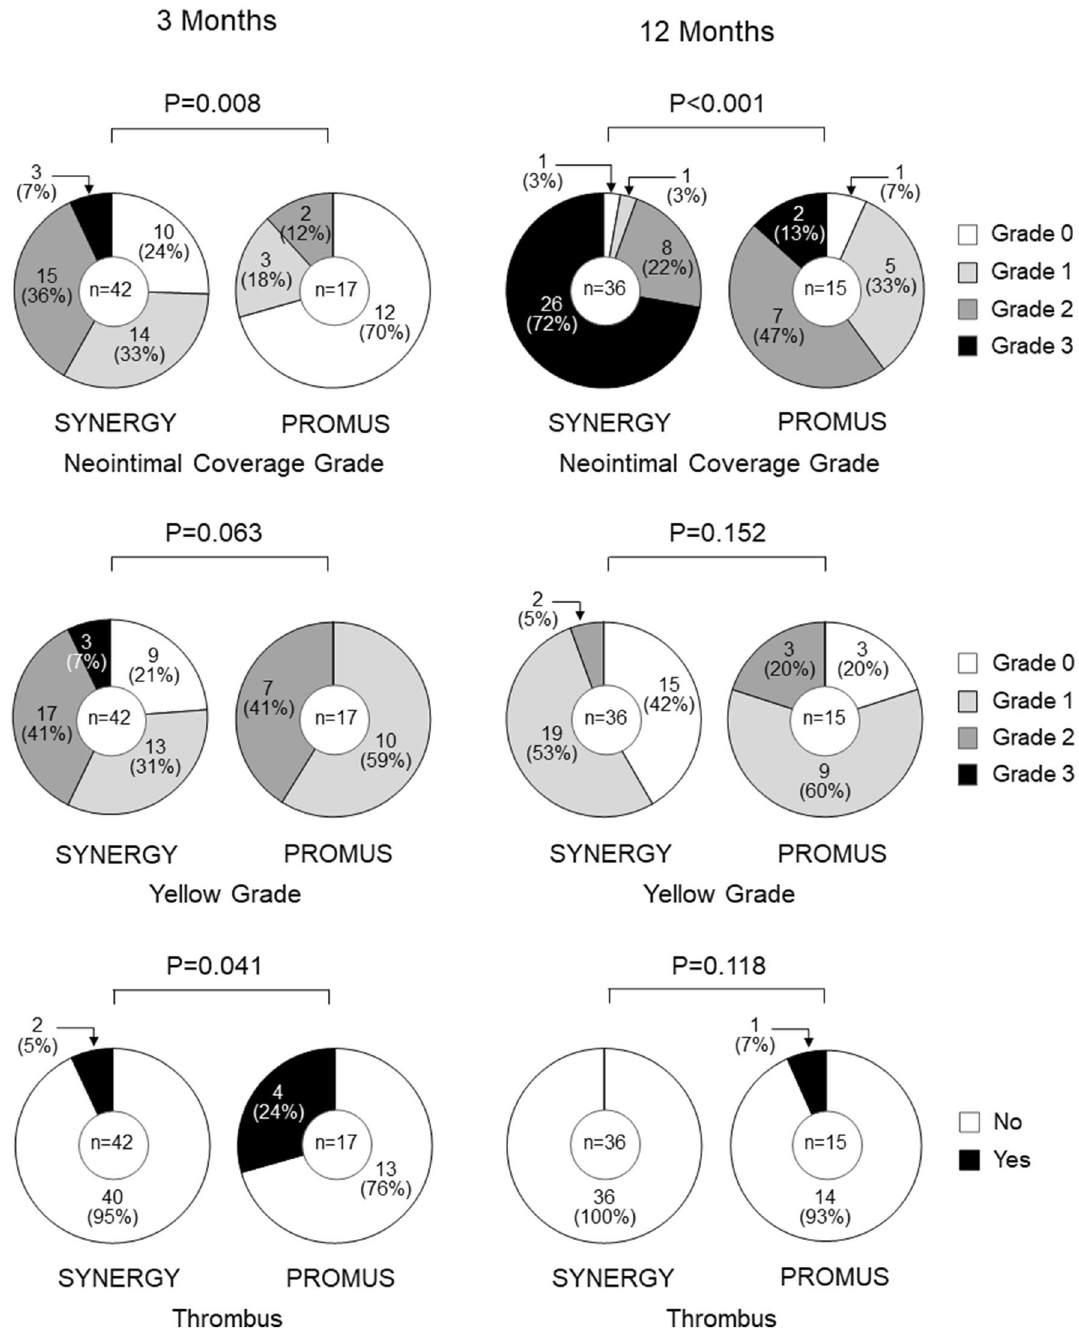
Figure 4. Neointimal coverage grade, yellow color grade and thrombus formation at 3 and 12 months by coronary